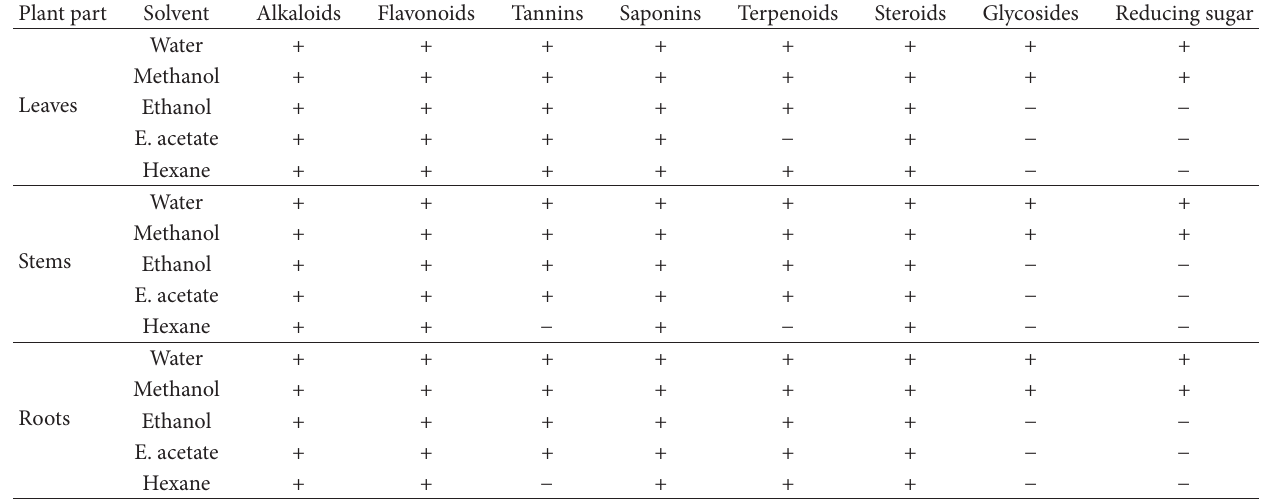
Table 2: Phytochemicals detected in different extracts of Adiantum capillus veneris .